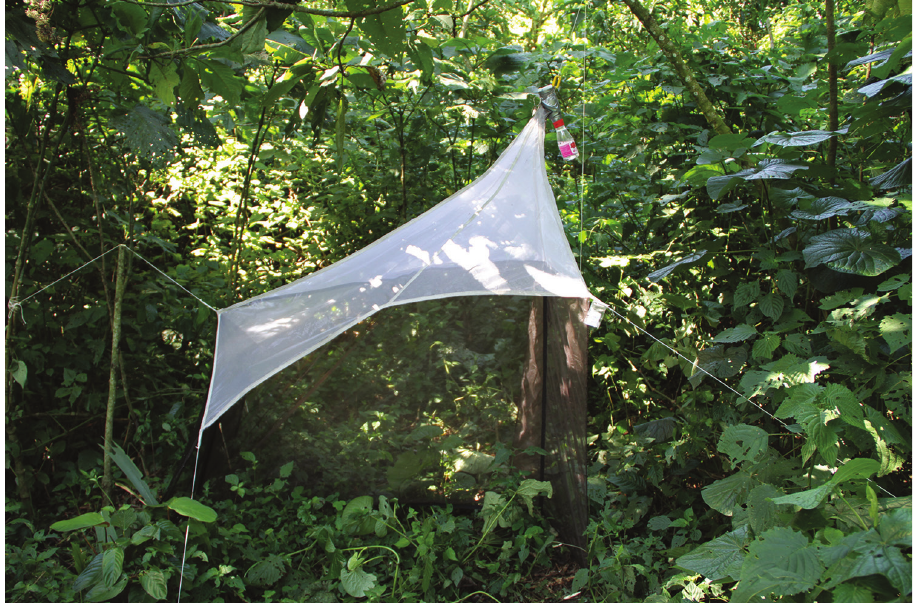
Figure 2. Malaise trapping at Kibale National Park in southern Uganda (Photo by O.